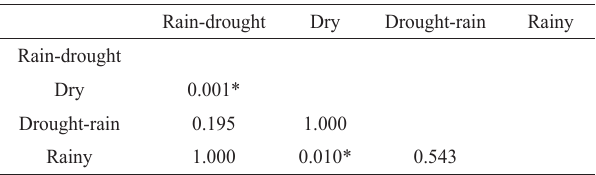
Fig. 2. Box-plot of Lithodoras dorsalis Repletion Index (RI%) at the rio Amazonas mouth, Brazil, from July 2010 to June 2011. Table 2. Probability values for pair-wise comparisons of the Repletion Index (RI%) among pluviometric periods for the rock-bacu Lithodoras dorsalis , sampled in the rio Amazonas mouth region, Brazil. (*) Significant values.